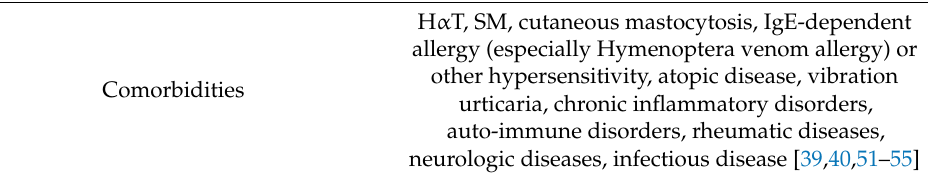
Table 1. Factors predisposing to the development of MCASs. Genes encode IL-4 or IL-6 , the production of IgE, and/or the regulation of the expression of the IgE receptor on MCs [30–33]; genes encode IL-13 [30,34]; the KIT mutation D816V [35–37]; genes encode Genetic factors angiotensinogen, angiotensin-converting enzymes, and chymase [38–41]; extra copies of the TPSAB1 gene encoding for alpha tryptase [42,43] Animal venoms (e.g., Hymenoptera insect, snake, black widow spider, scorpion); hypersensitivity to food (e.g., seafood, tuna fish, salt fish, uncooked anchovies, scombroid, food poisoning); alcohol; medications (e.g., antibiotics, non-steroidal anti-inflammatory drugs (NSAIDs), morphine, neuromuscular blocking agents, radiocontrast media, general anesthesia); Environmental factors physical stimuli (e.g., biopsy, endoscopy, vibration, exercise, pressure, friction, heat); infections (e.g., Ebstein–Barr virus (EBV), varicella zoster virus (VZV), herpes simplex virus (HSV), cytomegalovirus (CMV), human immunodeficiency virus (HIV), influenza, dengue, Ebola, Helicobacter pylori, helminthic parasites); stress [44–50]. H α T, SM, cutaneous mastocytosis, IgE-dependent allergy (especially Hymenoptera venom allergy) or other hypersensitivity, atopic disease, vibration Comorbidities urticaria, chronic inflammatory disorders, auto-immune disorders, rheumatic diseases, neurologic diseases, infectious disease